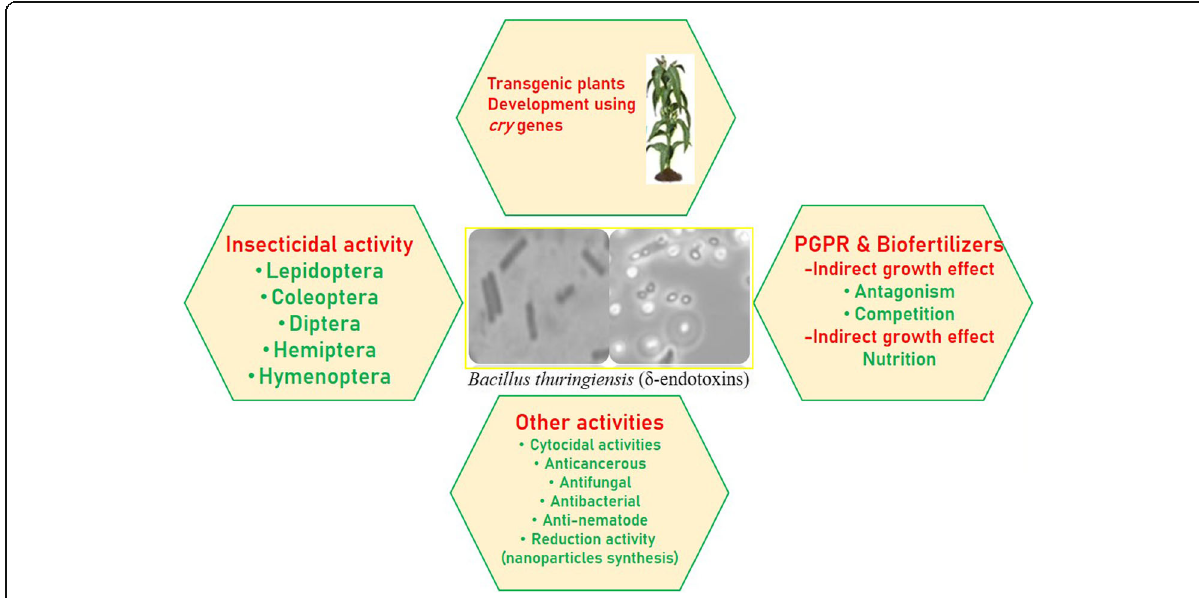
Fig. 1 Applications of Bacillus thuringiensis for sustainable